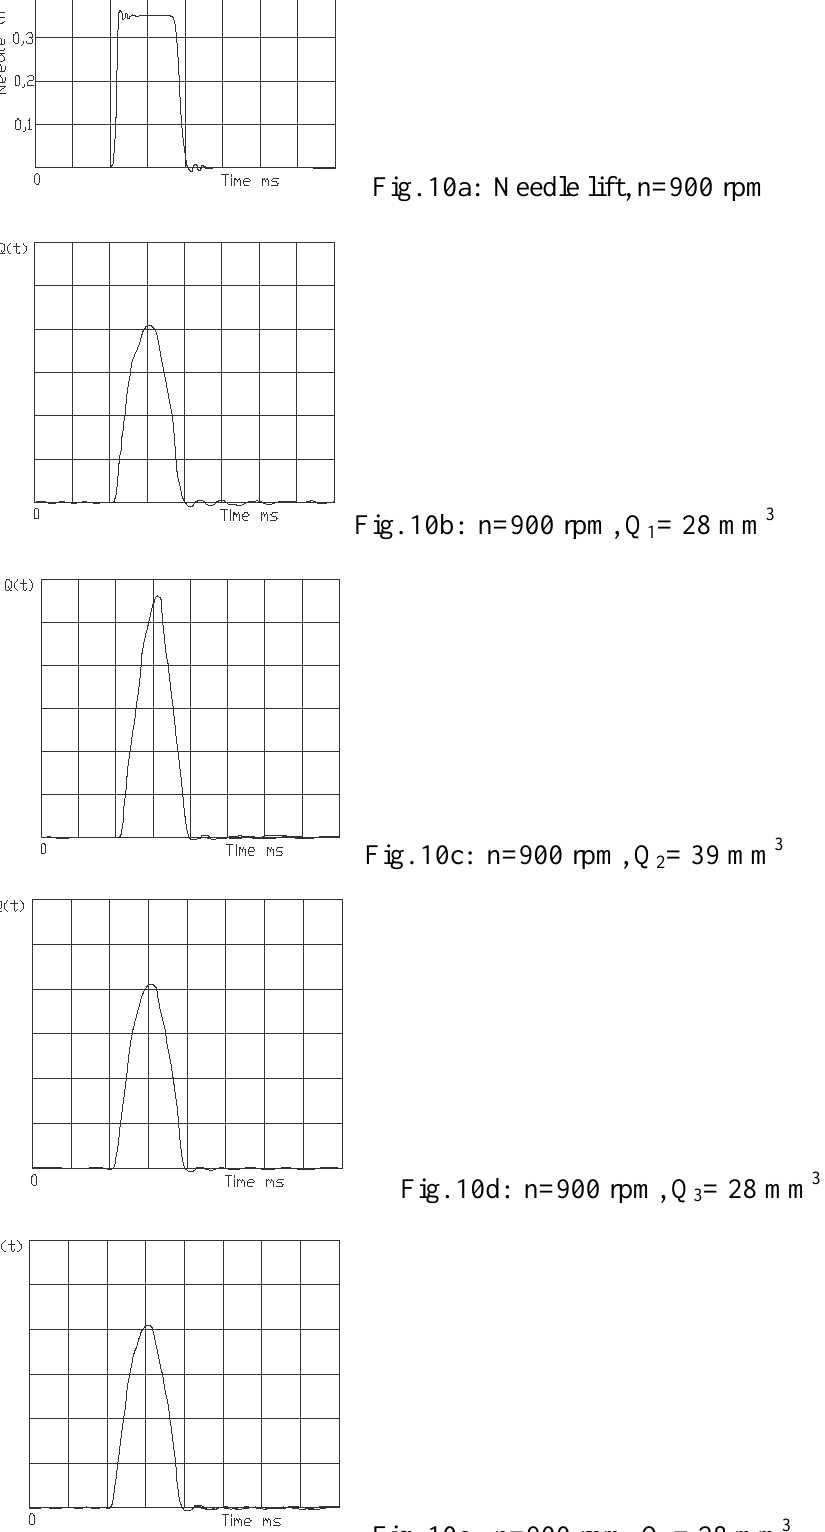
= 28 mm 3 4 =123 mm 3 per tot